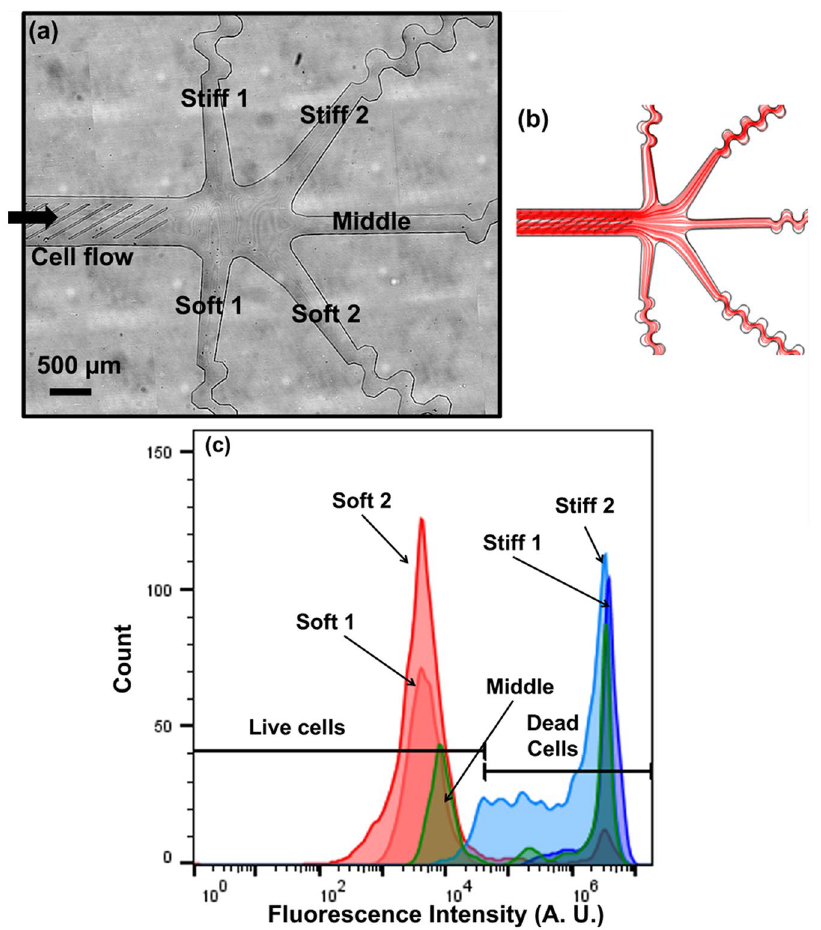
Figure 5. Five outlets device. ( a ) Schematic diagram of the five outlets device; ( b ) simulated streamline of fluid flow in the device ( c ) flow cytometry results obtained from different outlets of the device.